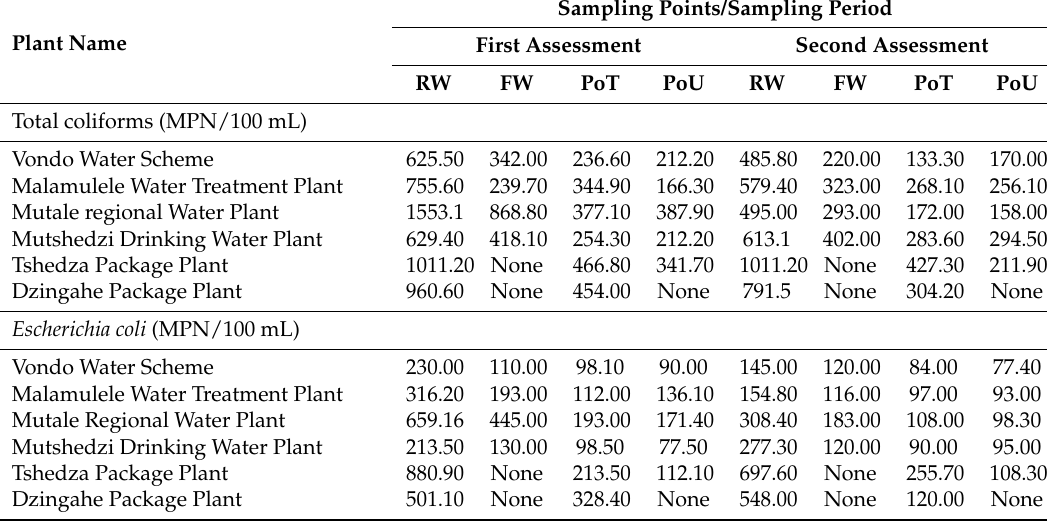
Table 7. Microbiological monitoring of water quality in selected plants: total coliforms and Escherichia coli (MPN/100 mL). MPN: most probable